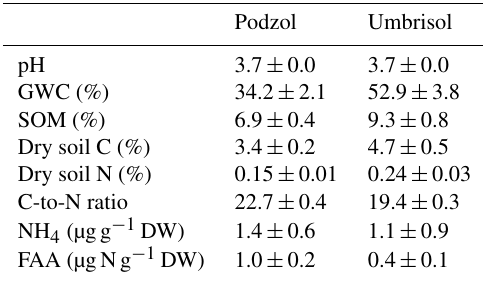
Table 1. Soil properties for the two soil types: Podzol and Umbrisol from Skogaryd. Averages with standard error. pH (in 1MKCl) gravimetric soil water content (GWC), soil organic matter (SOM), dry soil carbon (C), nitrogen (N), C-to-N ratio of soil, soil content of NH 4 (µgg − 1 DW), and total free amino acid content (FAA in µgNg − 1 DW). Podzol